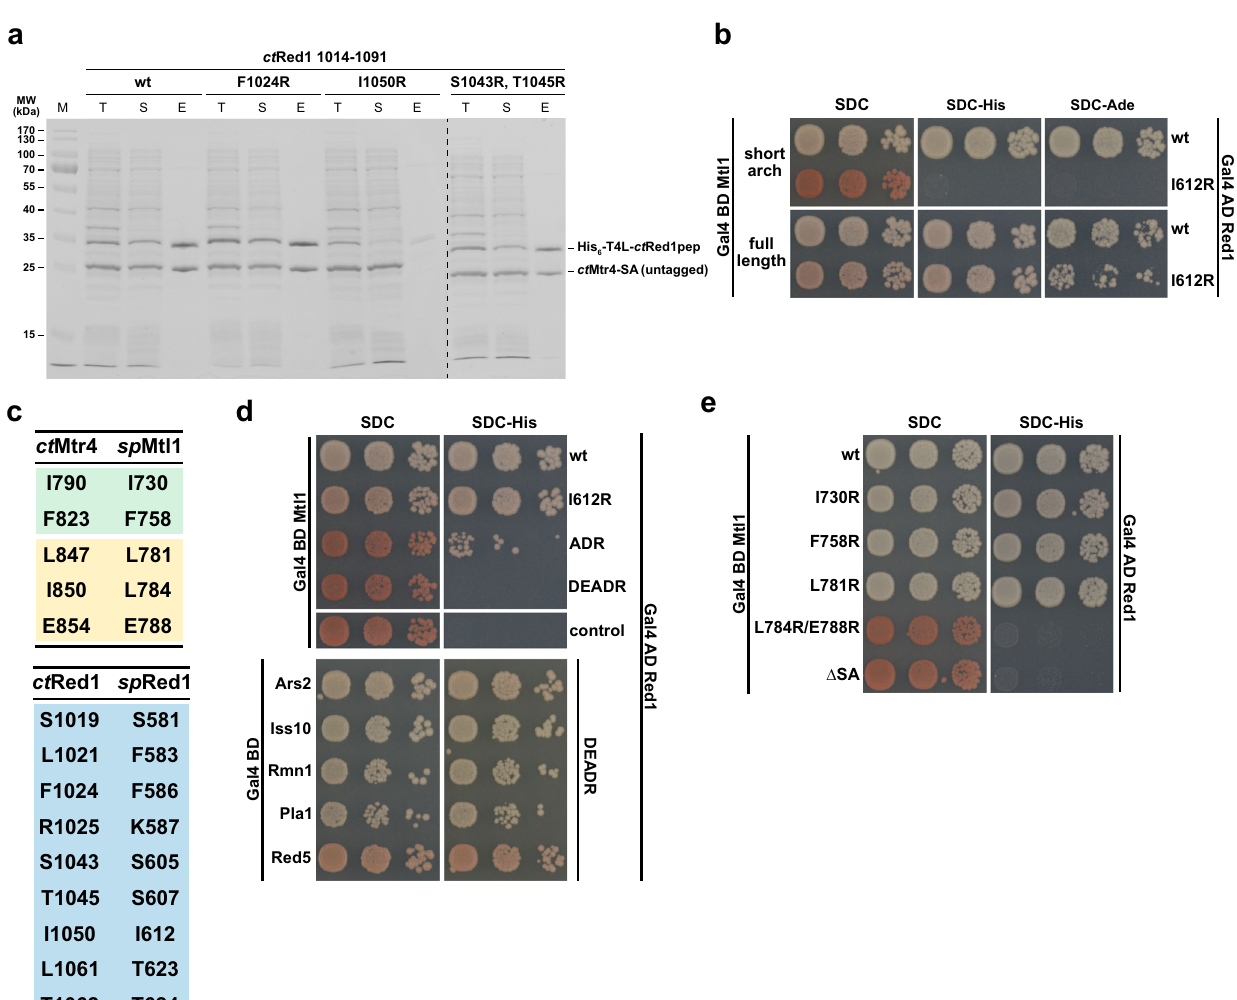
Fig. 5 Mutation analysis of the Mtr4/Mtl1 – Red1 interface. a Coomassie stained SDS-PAGE analysis of co-expression and puri fi cation of T4L- ct Red1 pep wild type (wt) and mutant variants. While wt T4L- ct Red1 pep co-puri fi es untagged ct Mtr4 SA , the I1050R mutant does not. F1024R and the double S1043R, T1045R mutants had no effect on the ct Mtr4 – ct Red1 interaction. T Total, S soluble, E eluate. b Y2H analysis of sp Red1 I612R (I1050R in ct Red1) and sp Mtl1 short arch or full-length variants. While the short arch shows no binding, the full-length sp Mtl1 retained binding. c Table showing the mutated residues in Mtl1/Red1 and Mtr4/Red1 in S. pombe ( sp ) and C. thermophilum ( ct ), respectively (color code is as in Fig. 4). d The sp Red1 I612R mutant binds like wt. Mutations at I612R, F586A, and K587D (ADR) weakened the interaction. Addition of S581D and F583E mutations (DEADR variant) completely abolished binding. The DEADR variant retained binding to the remaining interaction partners in MTREC, which con fi rmed proper protein expression. e Y2H analysis of sp Mtl1 mutants for sp Red1 binding. The single-residue I730R, F758R, and L781R mutants showed no reduction in binding. The L784R, E788R double mutant did not interact with sp Red1, similar to our observation for the short arch deletion ( Δ